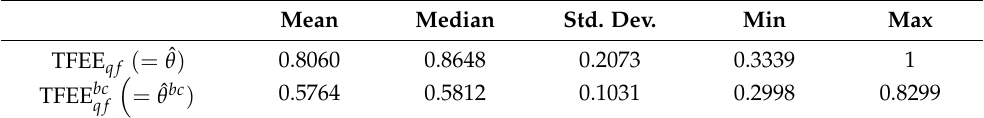
Table 4. Descriptive statistics of total-factor energy